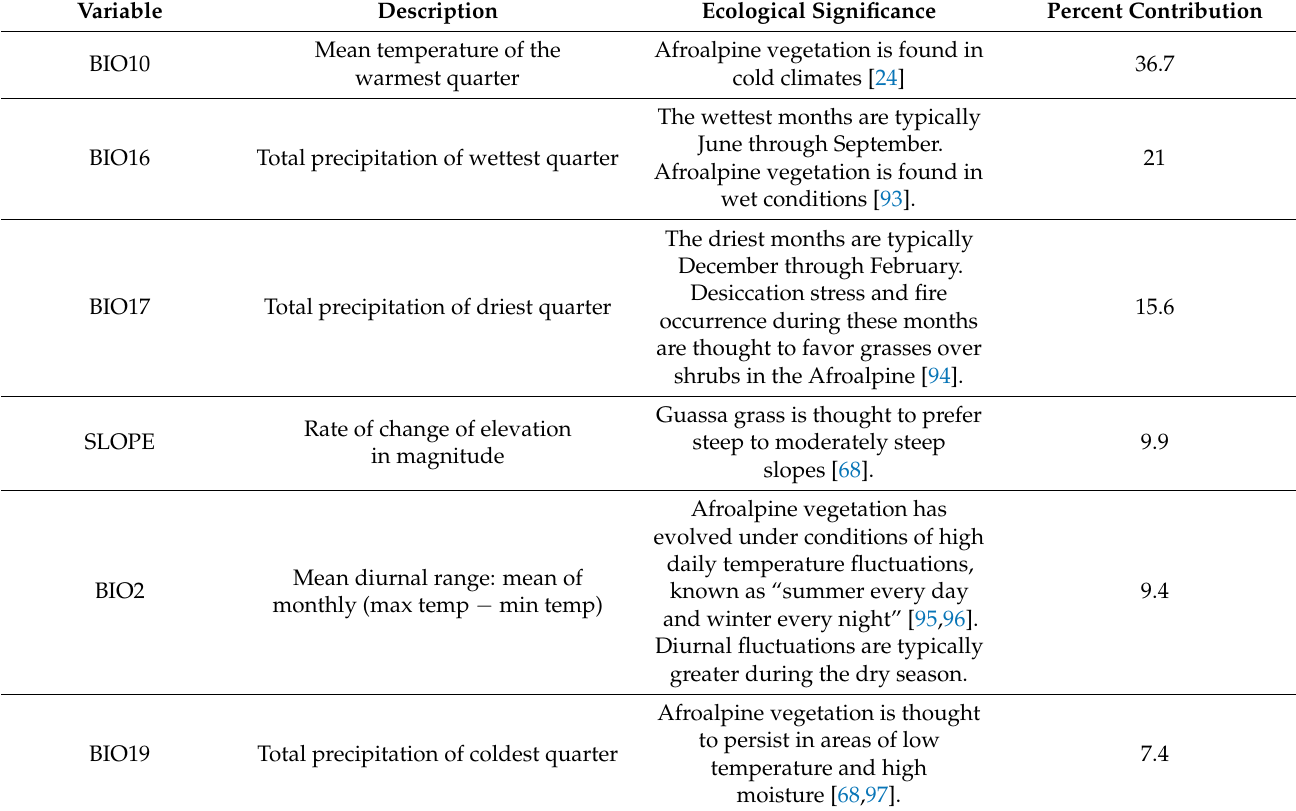
Table 1. Six environmental predictors, their ecological significance for modeling suitable habitat for guassa grass ( F. macrophylla ), and their percent contribution to final model